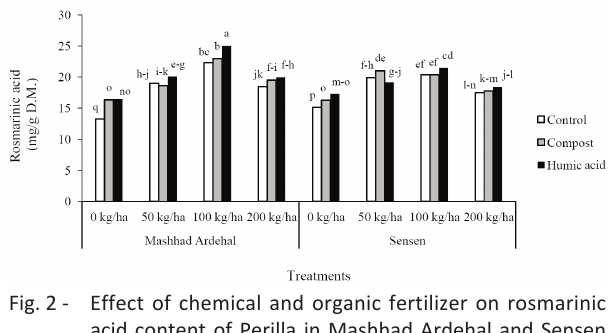
Fig. 2 - Effect of chemical and organic fertilizer on rosmarinic acid content of Perilla in Mashhad Ardehal and Sensen regions. Different letters in each column denote a signi- ficant difference at p≤0.05 (LSD test).